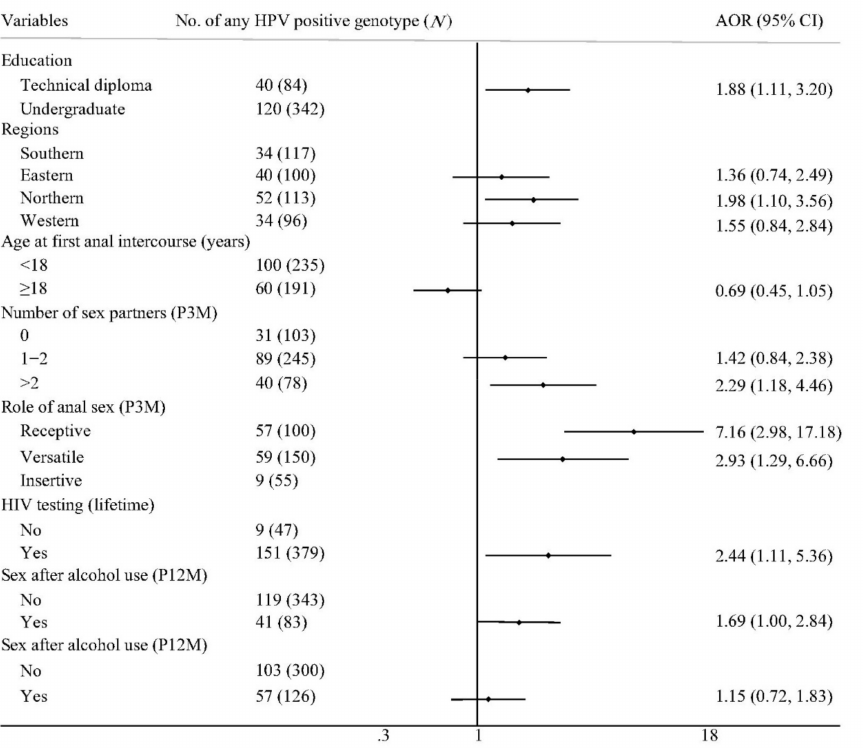
Figure 2. Factors associated with any anal HPV detection among MSM attending university in China. MSM: men who have sex with men, HPV: human papillomavirus, AOR: adjusted odds ratio, CI: confidence interval, P3M: past 3 months, and P12M: past 12 months. The symbol represents the AOR value and its 95% CI, the dot represents the AOR value, and the length of the line represents the 95% CI